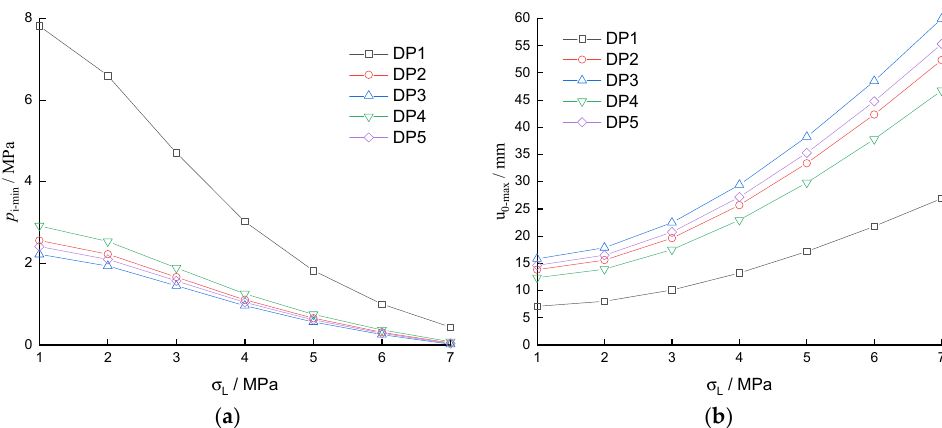
Figure 3. Effect of long-term strength on support: ( a ) optimal support force; ( b ) allowable maximum displacement.